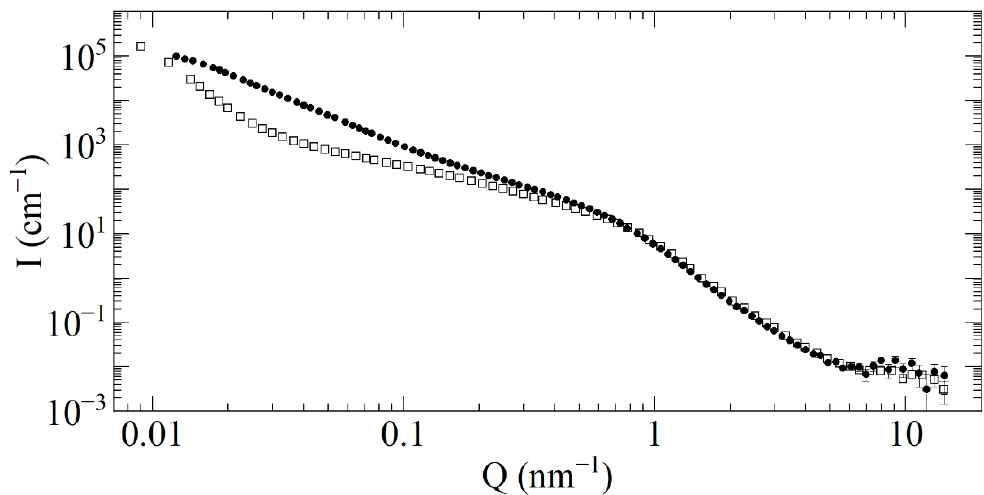
Figure 6. The intensity I (cm − 1 ) of scattering versus the neutron-transferred momentum Q (cm − 1 ) for the F-DNDs (solid circles) and DF-DNDs (open squares). Both curves are normalized to the equal sample density of 0.19 g/cm 3 .